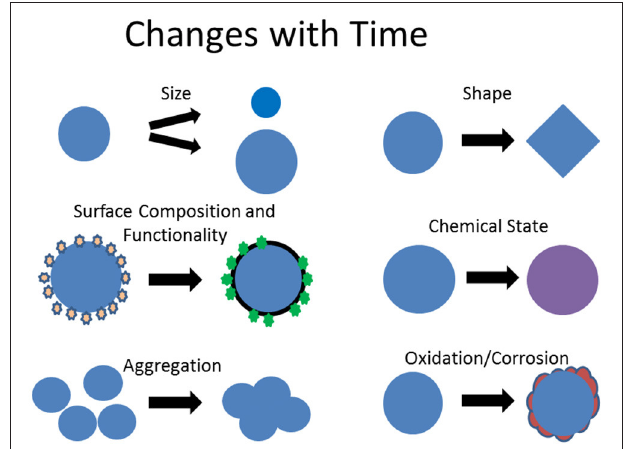
FIGURE 2 | Examples of how NPs can change as a function of time or in different physical, chemical, or biological environmental conditions.